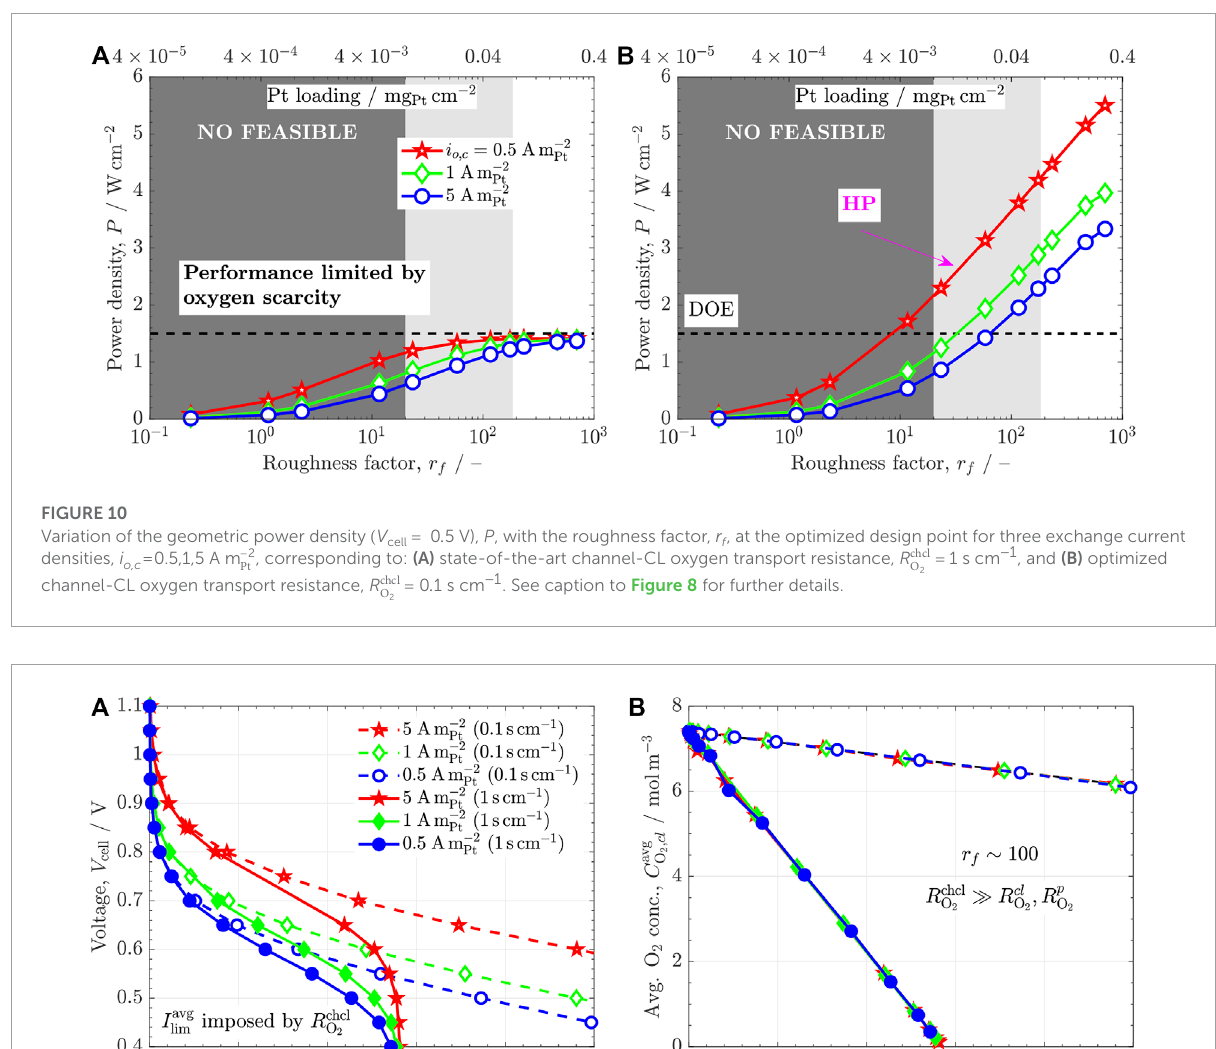
FIGURE 11 (A) Polarization curve, V cell − I avg , and (B) variation of the average oxygen concentration in the CL, C avg at r f ∼ 100 ( L Pt = 0.05 mg Pt cm −2 ). The results for three exchange current densities, i o,c =0.5,1,5 A m − 2 Pt , corresponding to both high and low channel-CL oxygen resistances, R